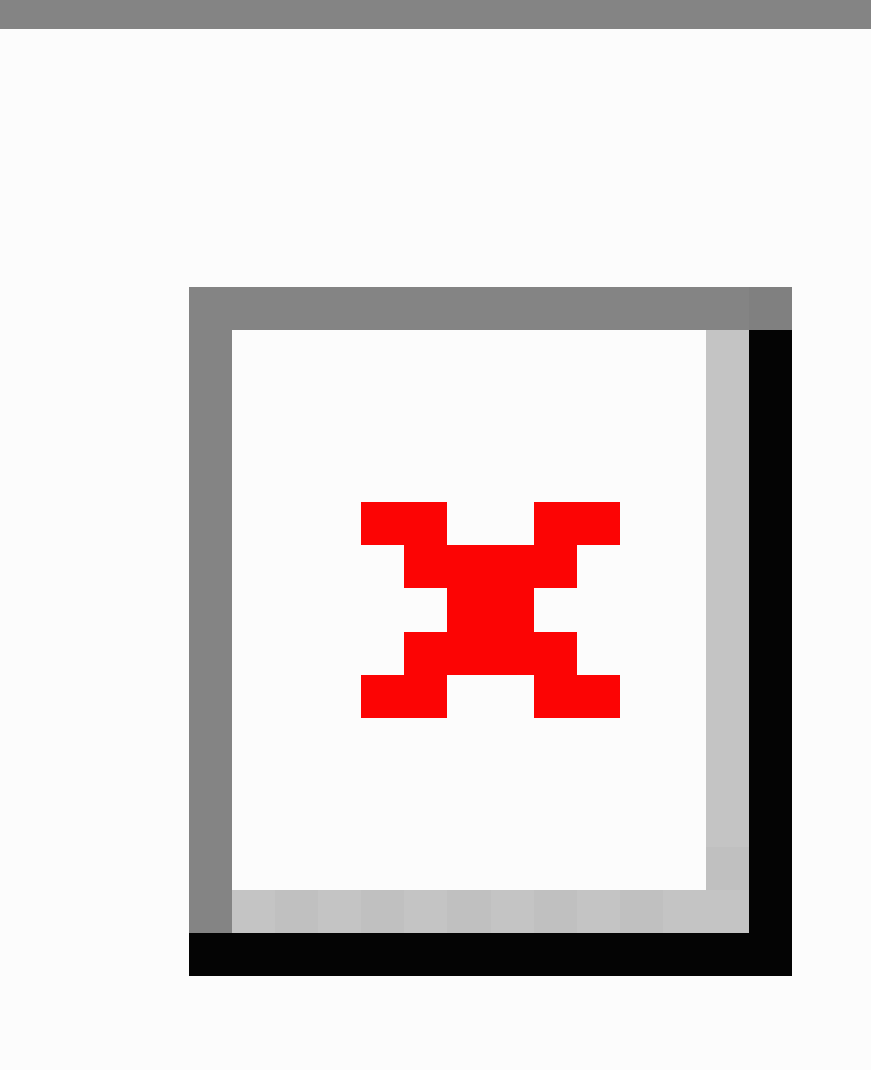
Figure 8. Evolution of interdisciplinary collaboration of PM research over time (2010-2014). The column represents a special interdisciplinary research, the interdisciplinary fields are distinguished by the color of columns, and the size of the column represents the scale of the special interdisciplinary research. The continuity of the column crossing the years indicates the continuity of the interdisciplinary